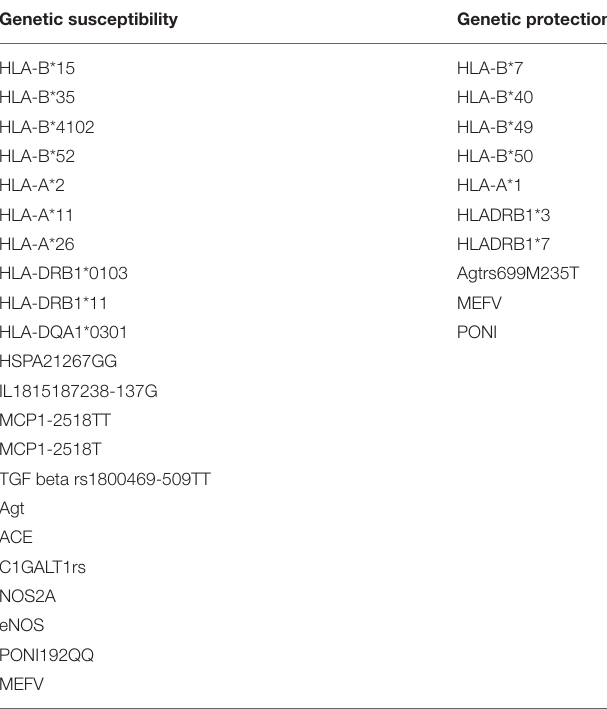
TABLE 1 | The specific genetic risk factors that have so far been identified predisposing an individual to acquiring IgA vasculitis and those implicated in being protective against the disease [adapted from He et al.